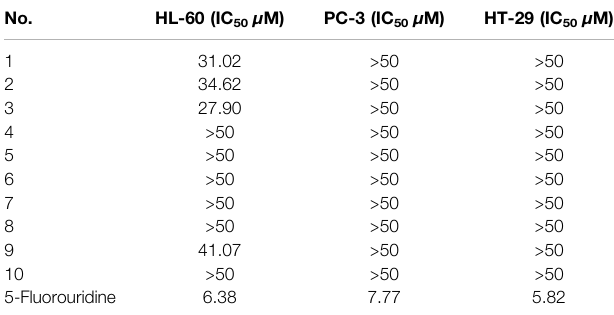
TABLE 3 | In vitro cytostatic activities of compounds (1 –